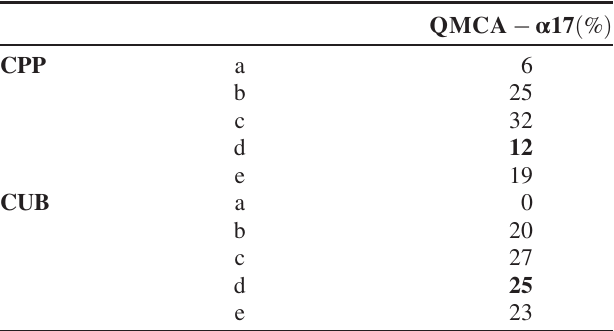
TABLE II. Distribution of students ’ responses for a MC question related to open-ended QMAT Q6. Since students could choose more than one correct response, the percents do not add up to 100%. The bold numbers represent the correct choices.